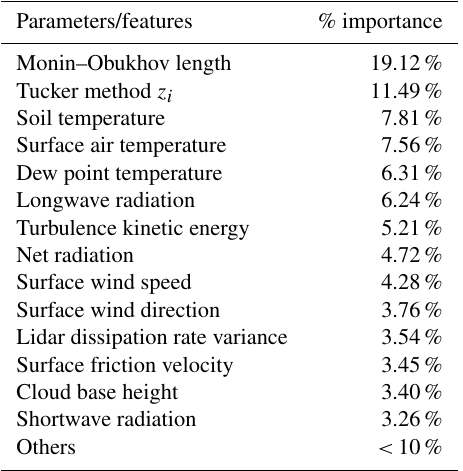
Table 5. Key parameter/feature unbiased importance estimates dur- ing nighttime